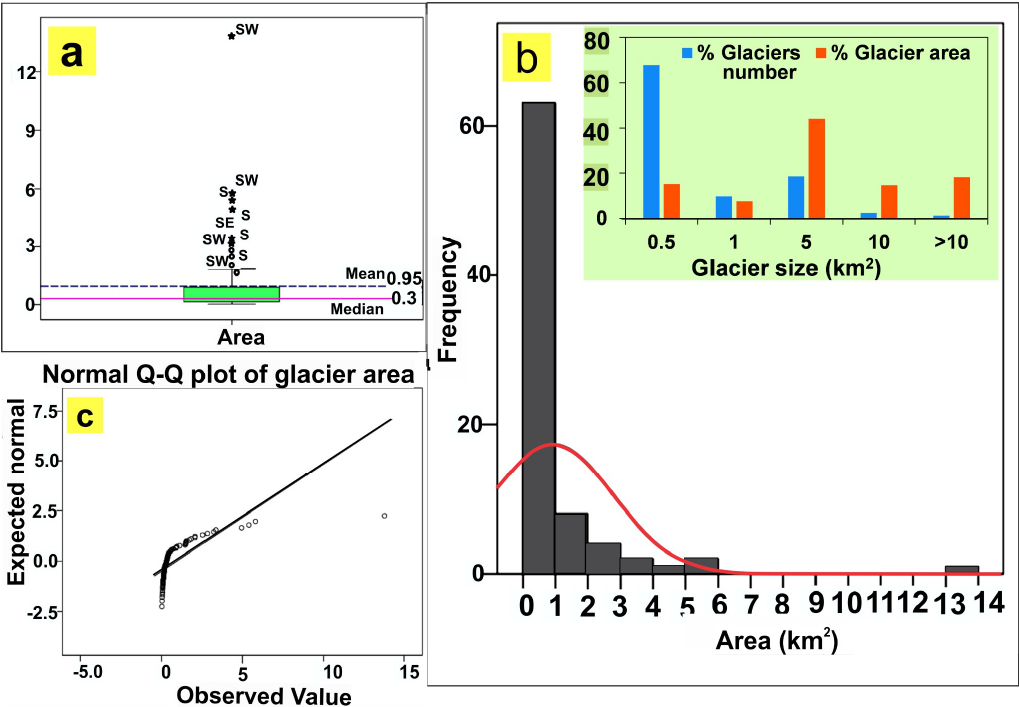
Figure 4. Distribution of glaciers (2016) ( a ) box-whisker plot of glacier surface area. The words SW,